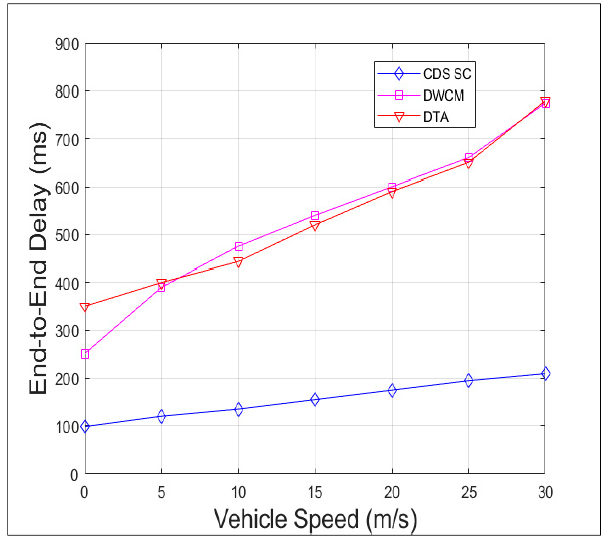
Figure 15. End-to-end delay versus vehicle speed.